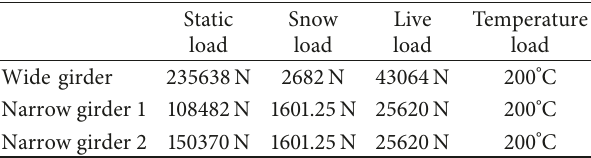
Table 2: The load information of girders.